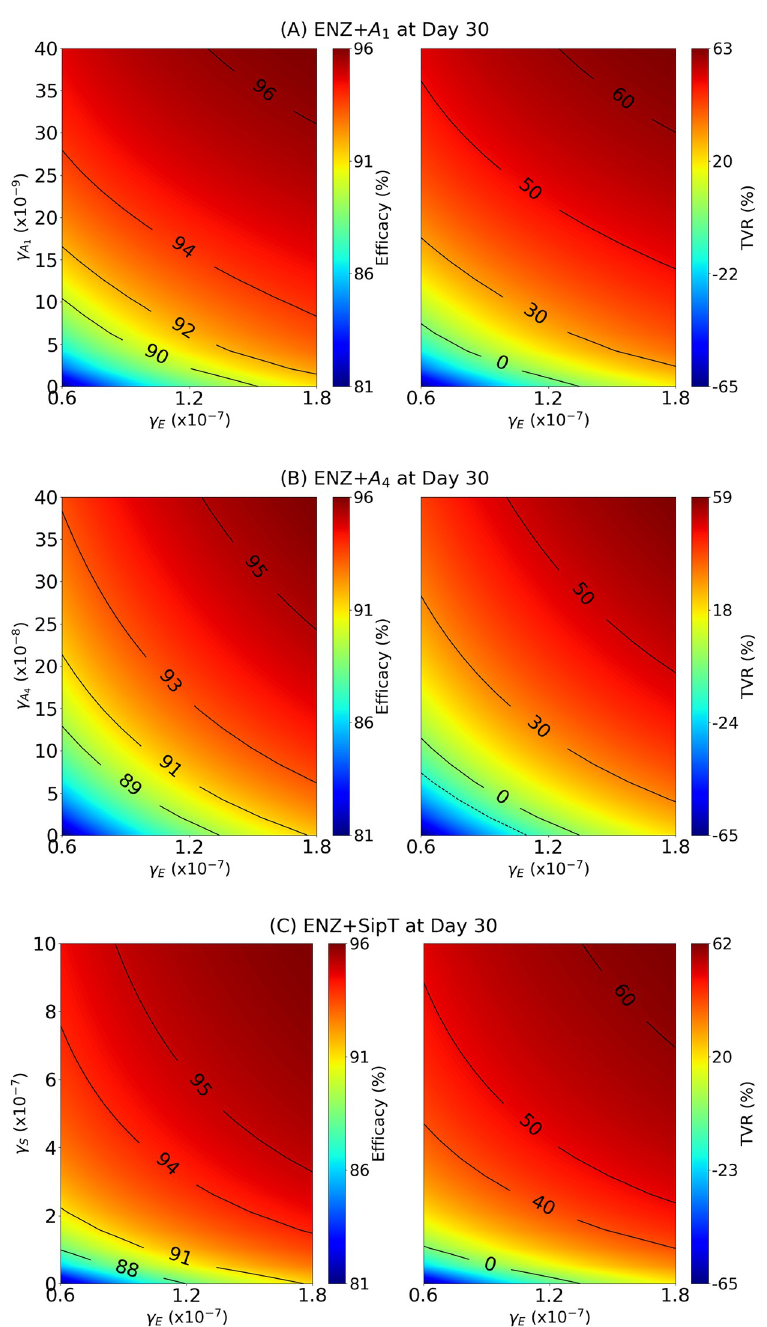
Fig 6. Benefit maps of combination therapy with ADT. γ between 0–10 × 10 − 7 g/cm 3 � d. The color columns indicate the efficacy (on left maps) and TVR (on right